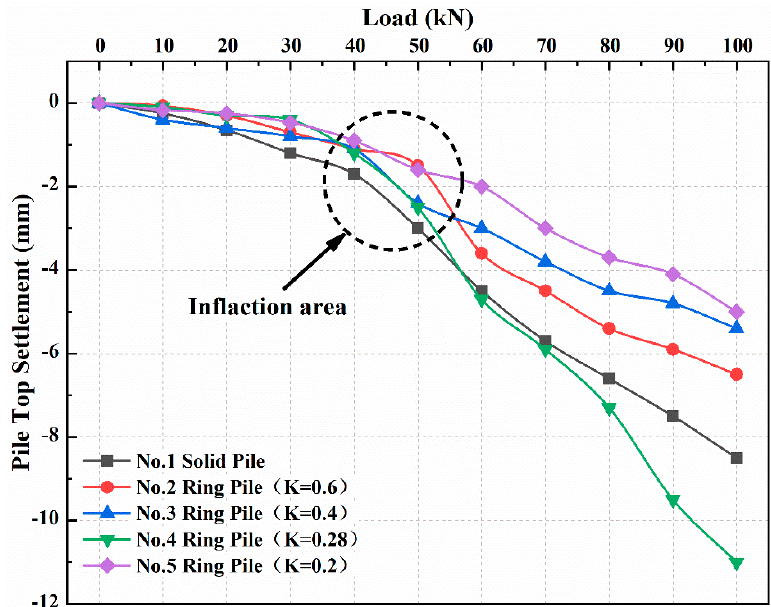
Figure 7. The settlement of pile top.